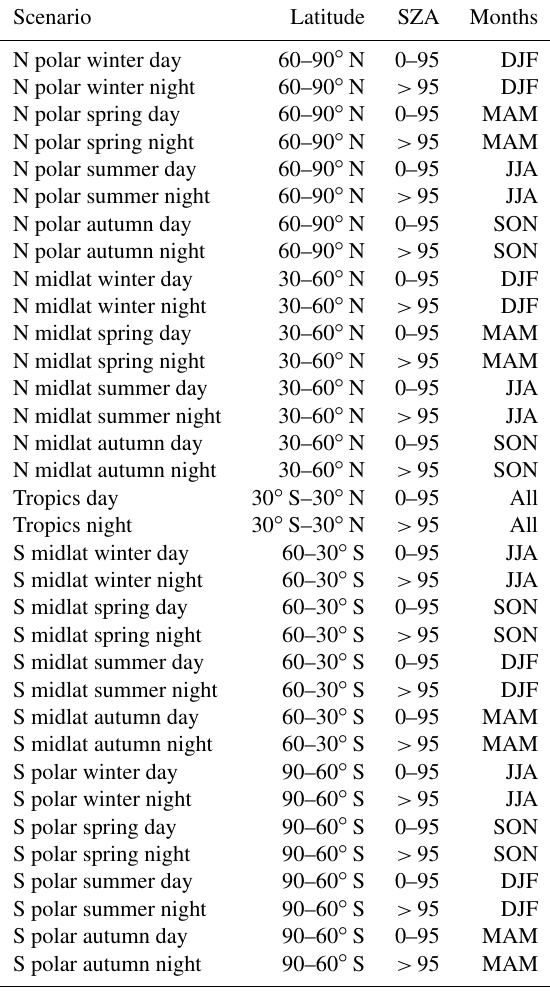
Table A6. Attribution of measurements to scenarios. Note: DJF is December–February, MAM is March–May, JJA is June–August, and SON is